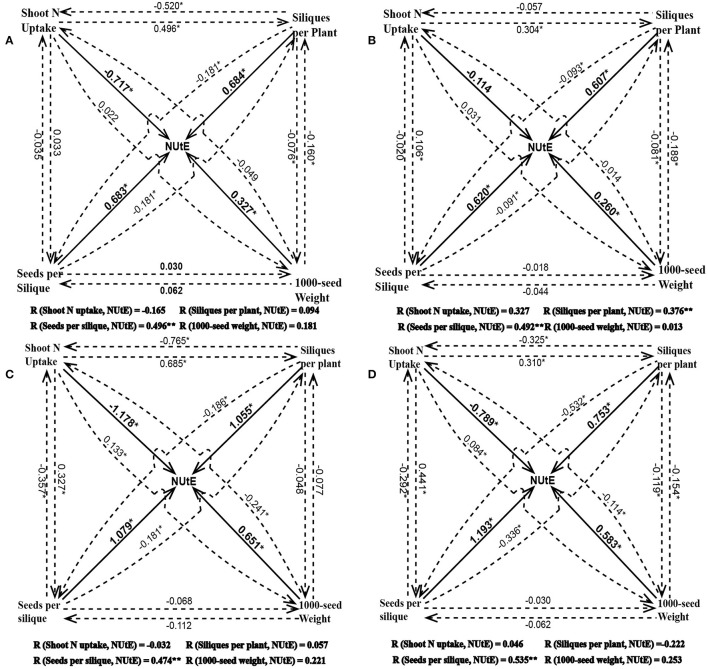
The Path coefficient for NUtE, yield components and shoot N uptake at high N treatment in the pot experiment (A), at low N treatment in the pot experiment (B), at high N treatment in the field trial (C), and at low N treatment in the field trial (D). The solid line represents the direct effect of a given parameter on NUtE and the dotted line represents the indirect effect of the corresponding parameter on NUtE via the other parameters. The value near a vector means effect of trait at the starting point on the trait at the terminal point of the vector (i.e., in A 0.683 is the direct effect value of seeds per silique on NUtE and −0.181 is the indirect effect value of seeds per silique on NUtE through siliques per plant). R is the Pearson coefficient of correlation (the final effect, i.e., 0.496 represents the sum of direct effect of seeds per silique on NUtE and the indirect effect of seeds per silique on NUtE through shoot N uptake, siliques per plant and 1000-seed weight). *represents p < 0.05.